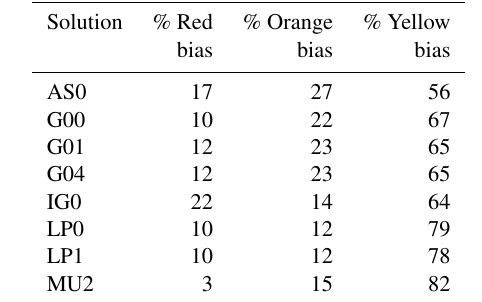
Table 3. Percentage of red, orange and yellow biases (see text) for each contributing solution.